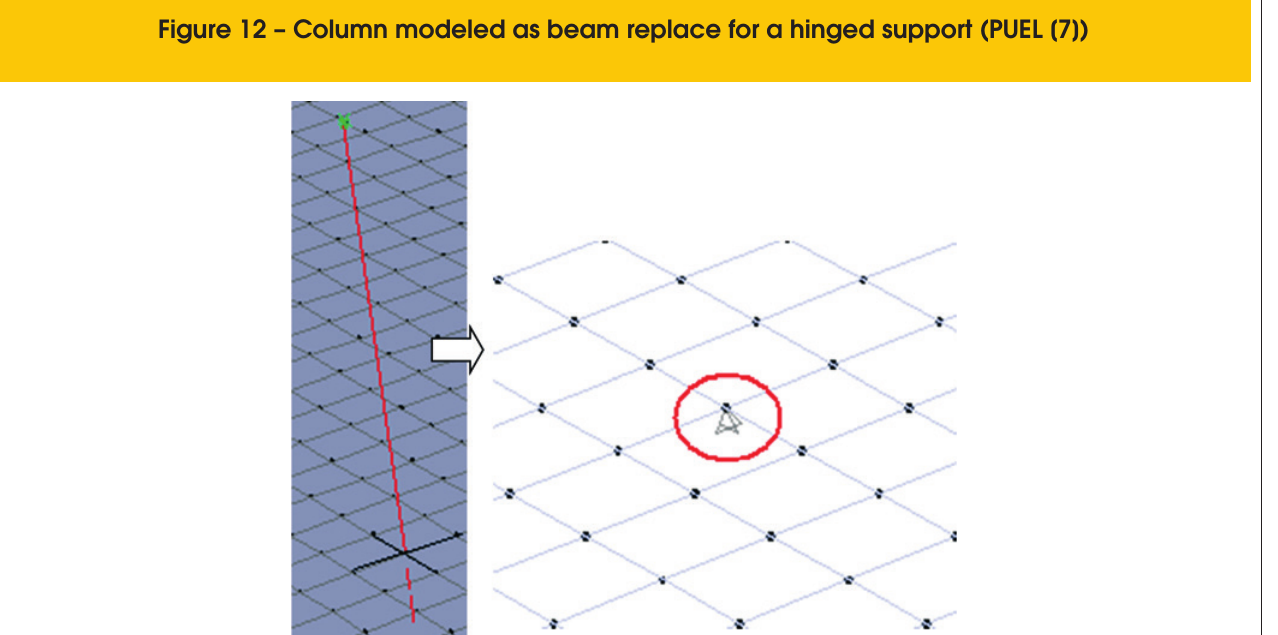
Figure 12 – Column modeled as beam replace for a hinged support (PUEL